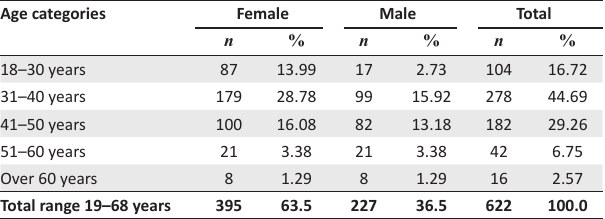
TABLE 2: Sample characteristics with gender ratios and mean ages.